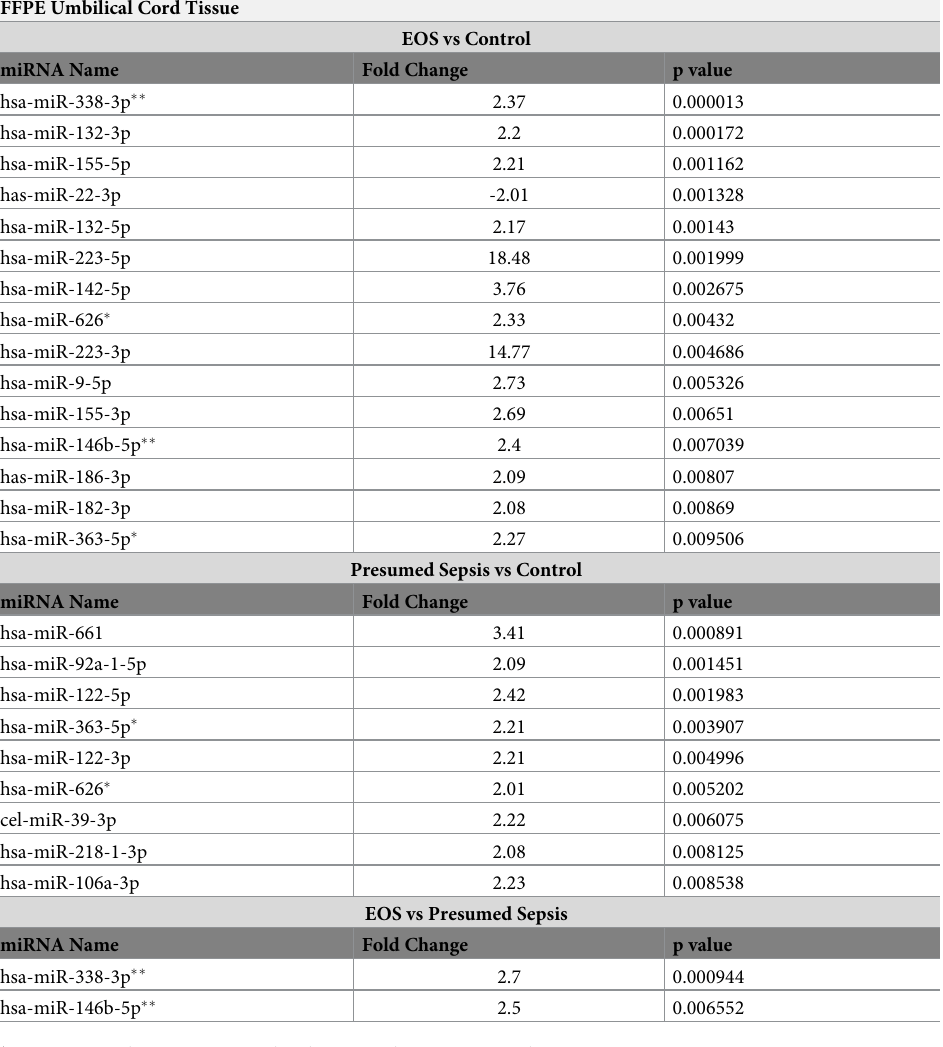
Table 3. Top miRNA differences between groups–FFPE umbilical cord. FFPE Umbilical Cord